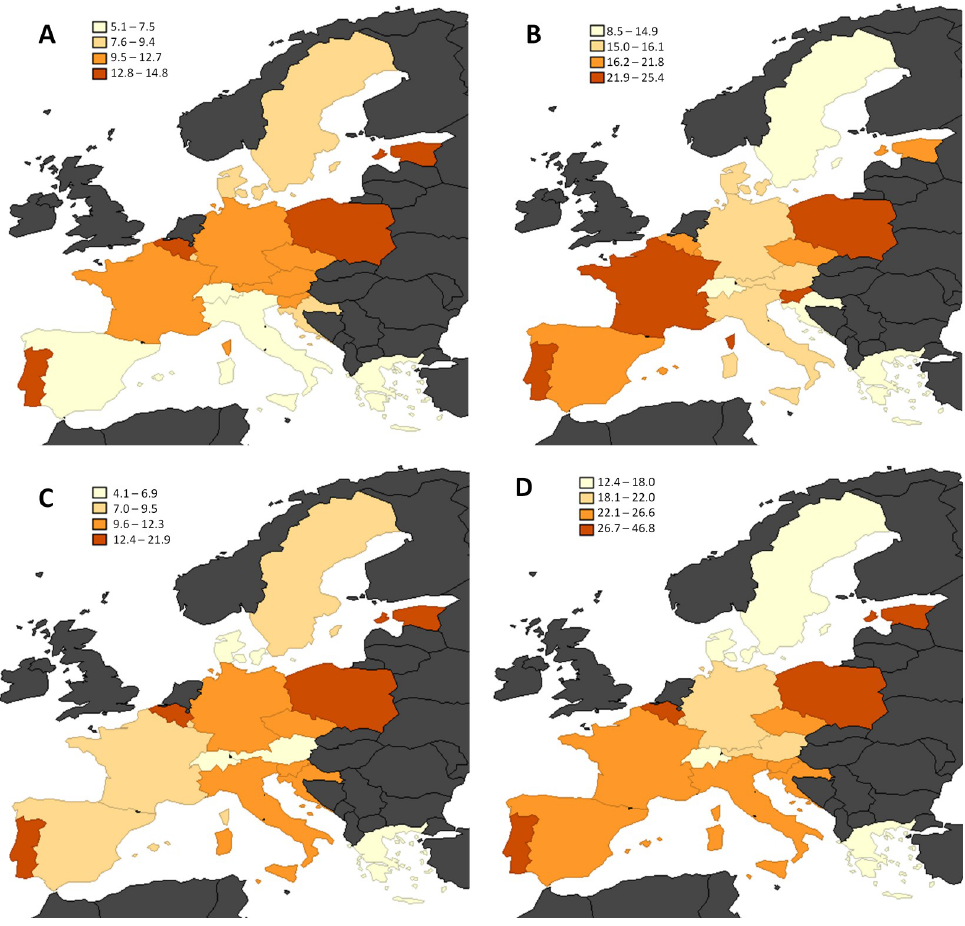
Fig 1. Prevalence of disability (1 or more BADL limitations), classified by quartiles, in 17 European countries in men aged 65–74 (A), men aged 75–84 (B), women aged 65–74 (C) and women aged 75–84 (D) in 2015.